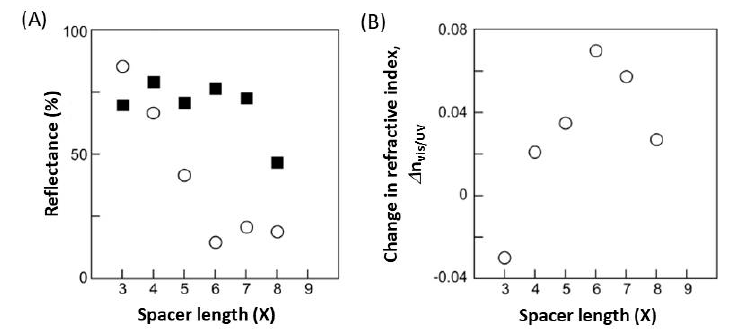
Figure 10. Change in reflectance of the PXAz (X = 3–8)/PVA 20-multi-bilayered film by irradiation with unpolarized visible light (436 nm, 140 mW/cm 2 , 15 min; open circle) and following UV light (365 nm, 40 mW/cm 2 , 15 min; closed square) ( A ) and calculated refractive indices ( B ) of PAz against the methylene spacer length from three to eight. Source: Yagi et al. 2014 [42]. Copyright 2014. Reprinted with permission from Elsevier Ltd.